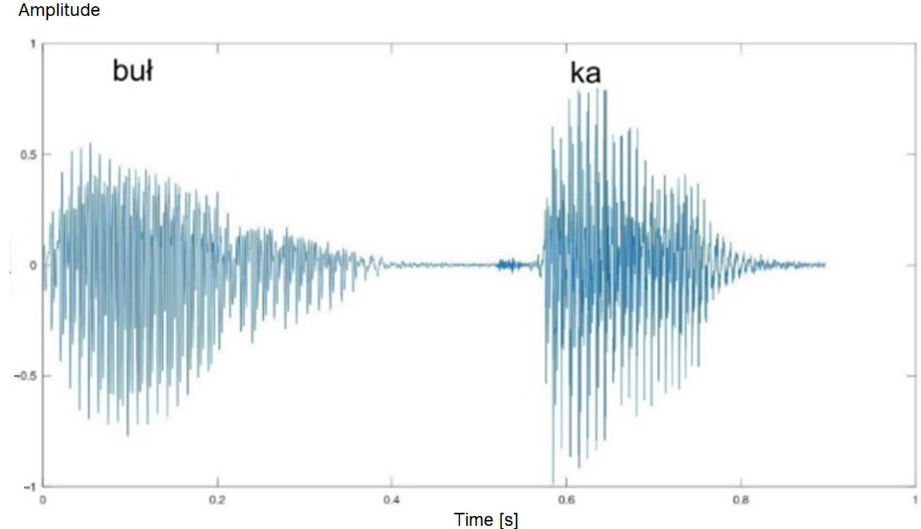
Figure 5. Time waveform of the word “bułka” (eng. a bread roll) — healthy man. Two phonetic segments are visible.